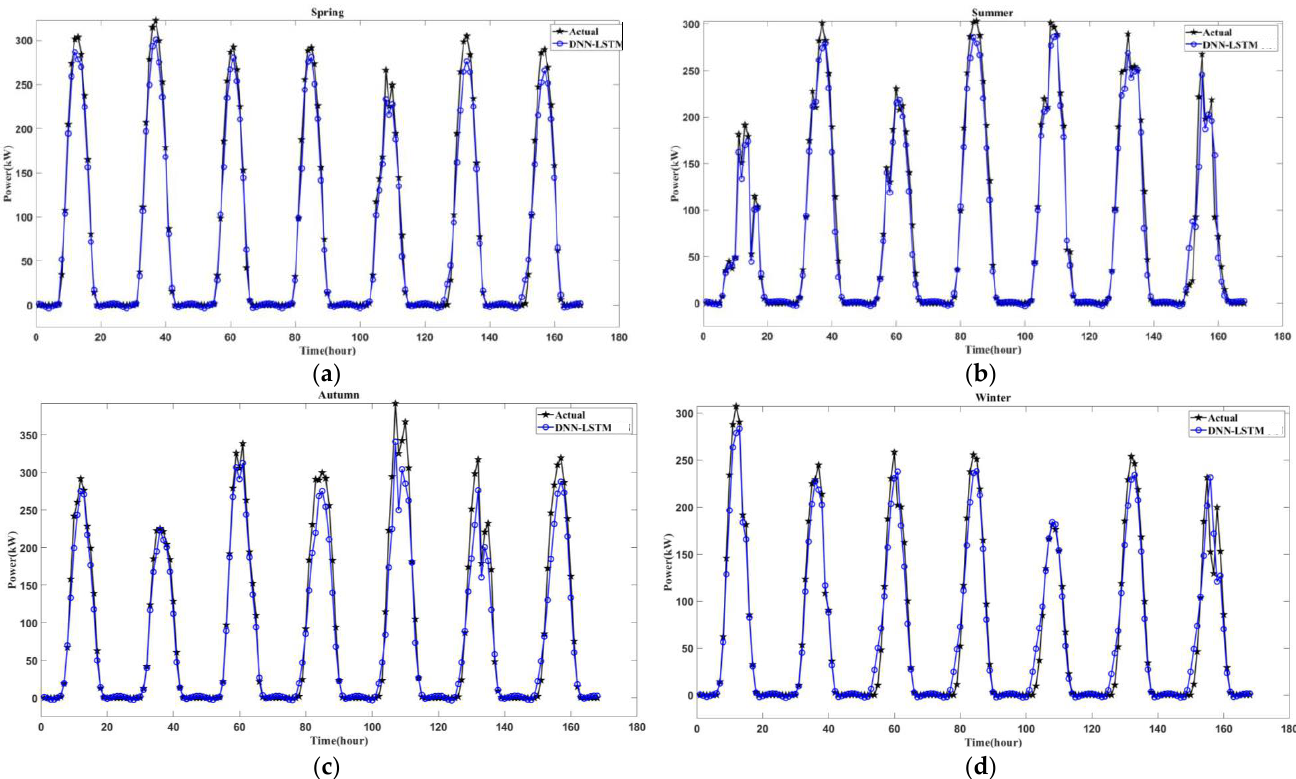
Figure 9. Hourly power generation forecasting results by DNN- LSTM during one week for solar power plant D: ( a ) spring; ( b ) summer; ( c ) autumn; ( d ) winter. Table 8. Comparisons of performance indicators of five forecasting models for solar power plant